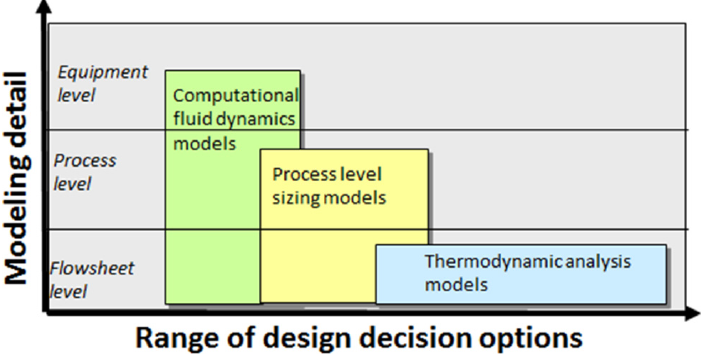
Figure 5. Equipment, process and flowsheet models with respect to modeling detail and range of design decision options which may be simulated at a reasonable computational